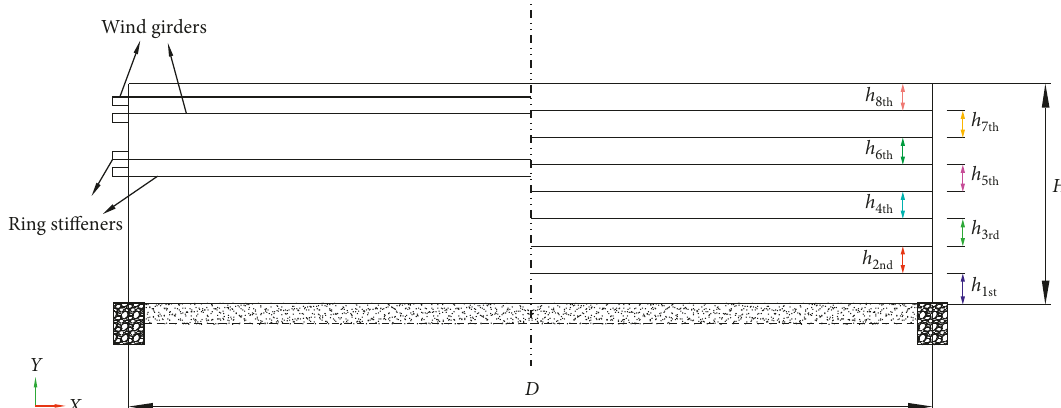
Figure 5: Structure diagram of the storage tank with 15